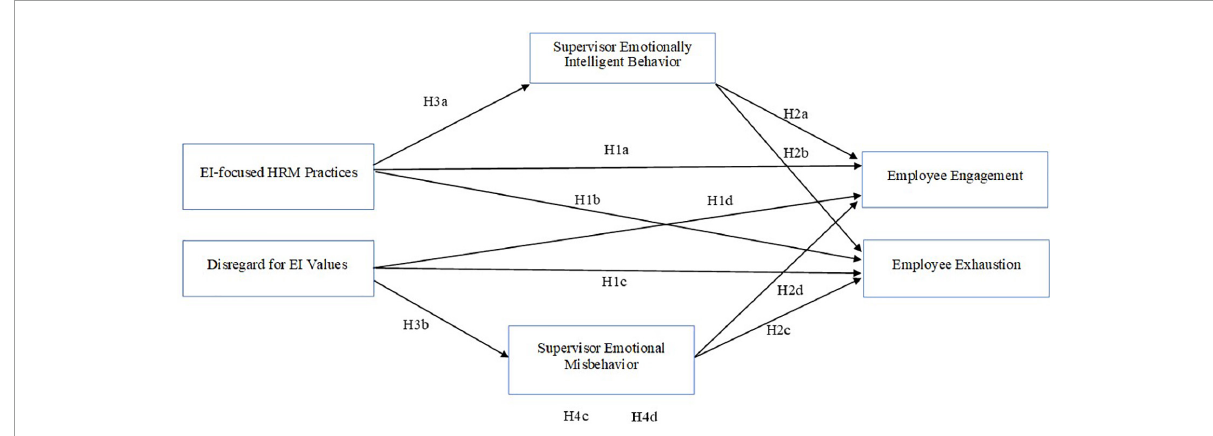
FIGURE1 A model of the process links EI-related organizational culture and employee engagement and